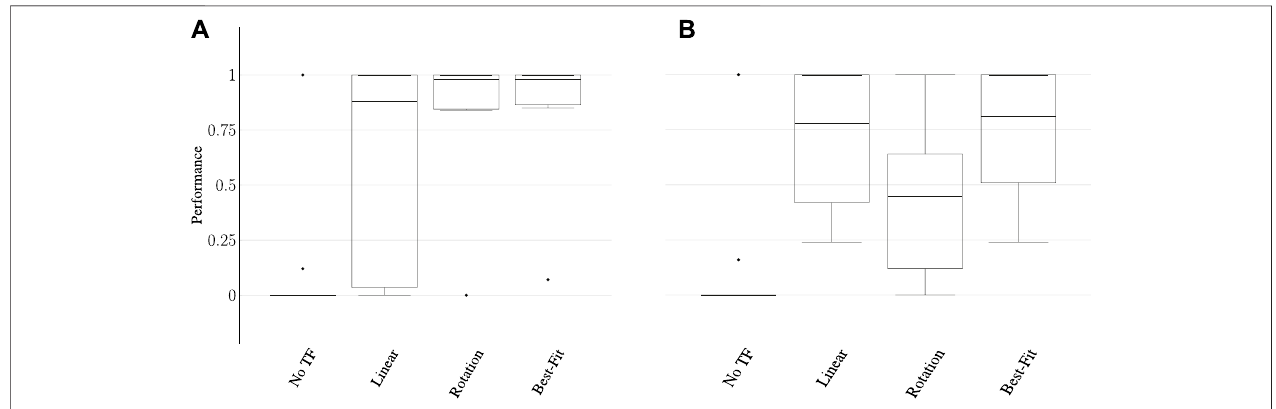
FIGURE 12 | Aggregate performance results for within-task transfer using the scrub-brush (A) and mug (B) as the replacement tool. Performance was measured for each task according to the metrics in Section 5.10 , and are scaled between 0 – 1. These results highlight the need for multiple tool transform models; while both models greatly outperform the baseline task performance (when no transform is used), note that neither model results in the best performance over all tasks and replacement tools. Using the best- fi t metric to select the more appropriate model for each tool-task pairing resulted in the best overall performance.